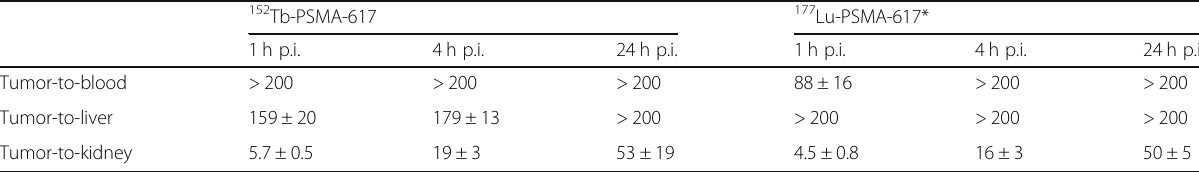
Table 2 Biodistribution of 152 Tb-PSMA-617 in PC-3 PIP/flu tumor-bearing mice